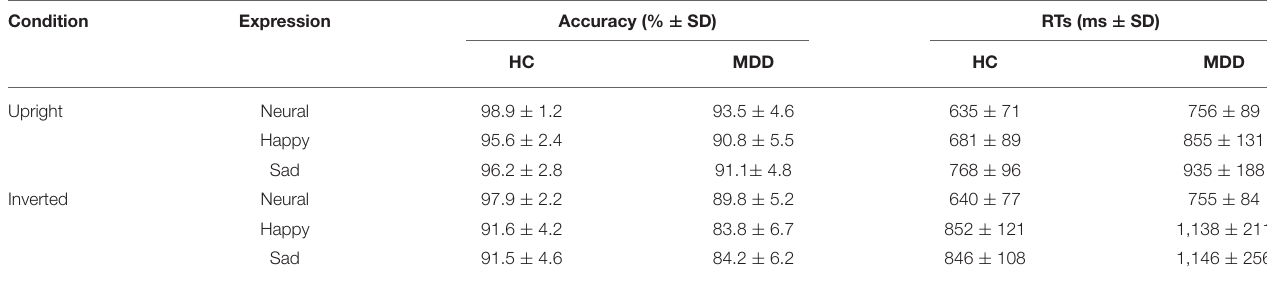
TABLE 2 | The accuracy rate (%) and reaction times (RTs) of classification of emotional faces in healthy controls (HC) and MDD patients,